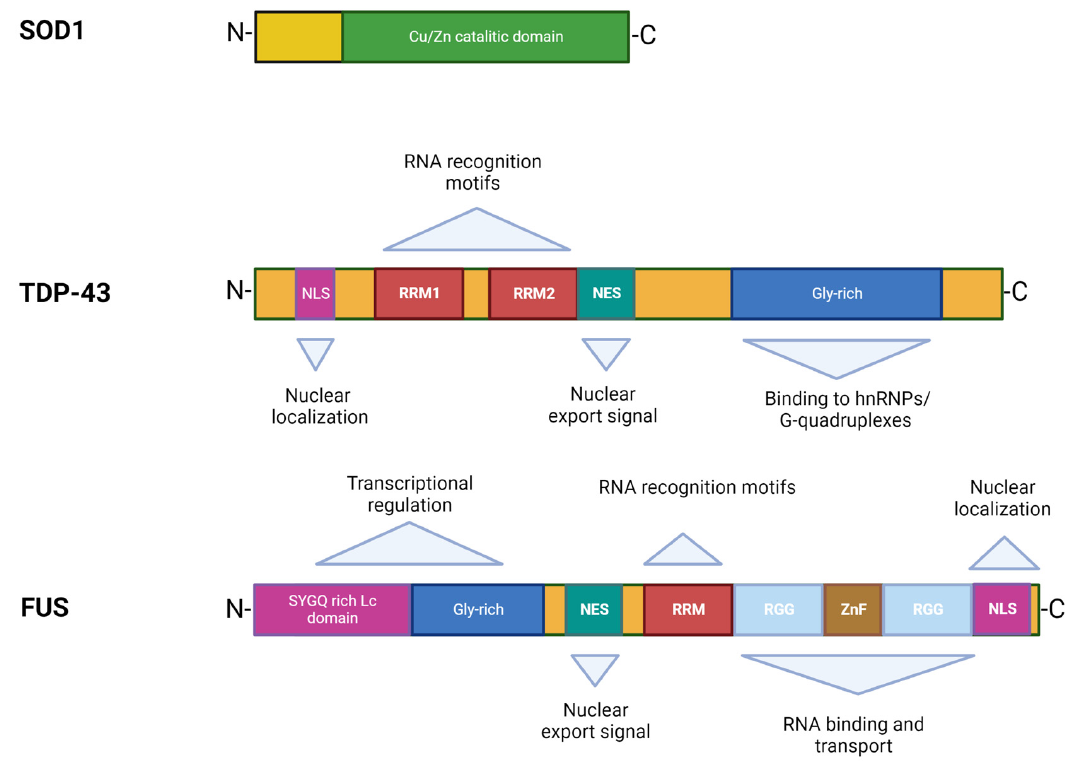
Figure 2. Structures and functional domains of SOD1, TDP-43, and FUS proteins.